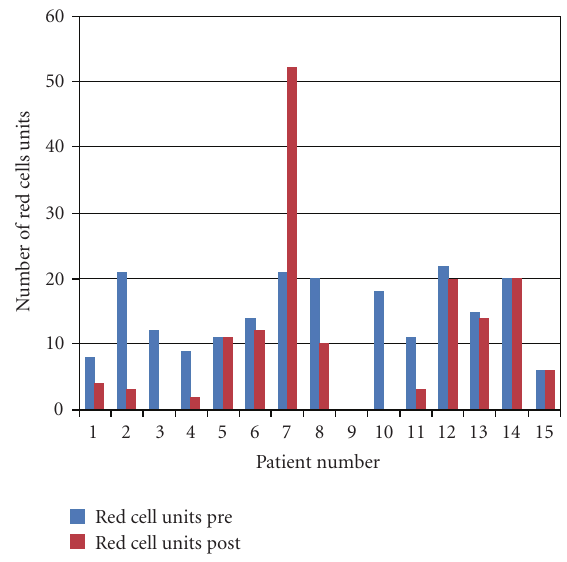
Figure 1: Red cell transfusion requirements within 24 hours before and after the administration of rVIIa for major obstetric